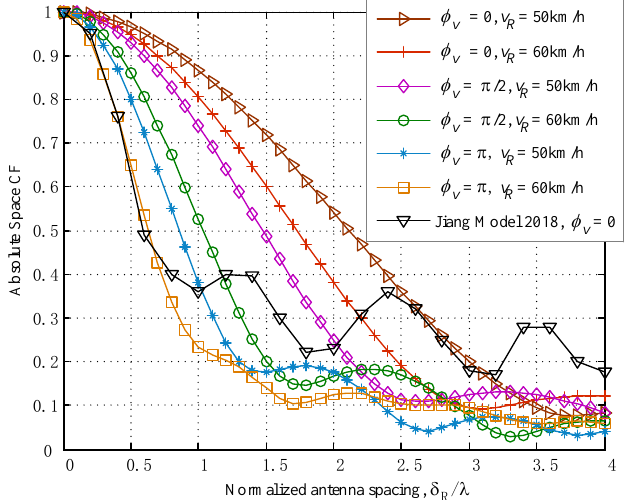
Figure 3. Proposed time-variant space CFs for the NLoS paths in the case of different moving properties φ v and v R , when t = 2 s , N = 4, R = 6 m, M T = M R = 4, γ T = 2 π /3 , γ R = π /6 [10].